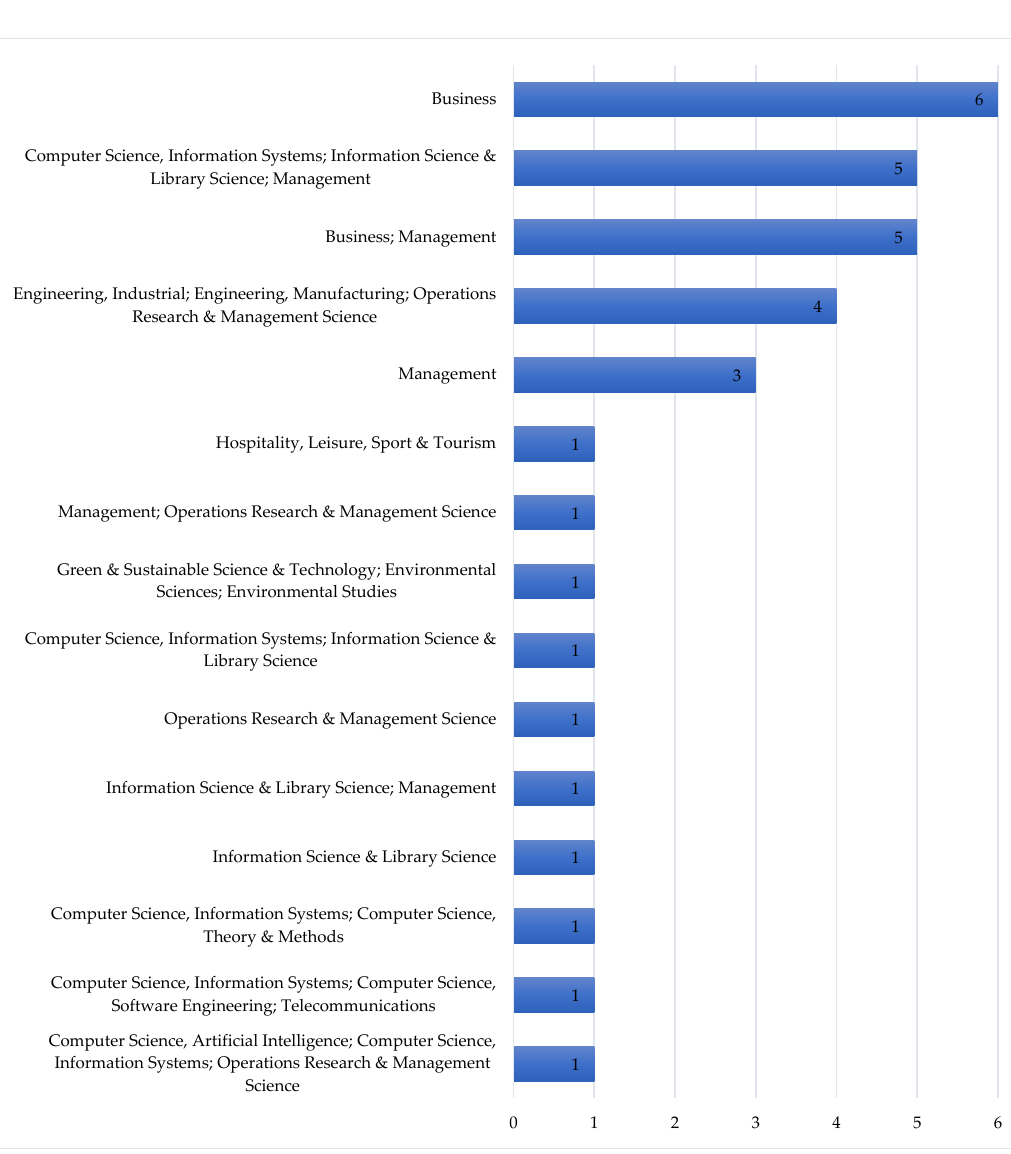
Figure 1. The WoS-related distribution of the papers.